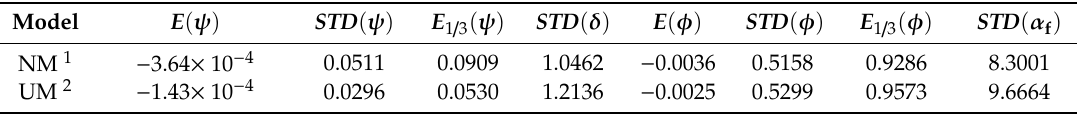
Table 4. Statistical simulation results of the ship roll / yaw motions based on nominal / uncertain model at the encounter angle of 90 ◦